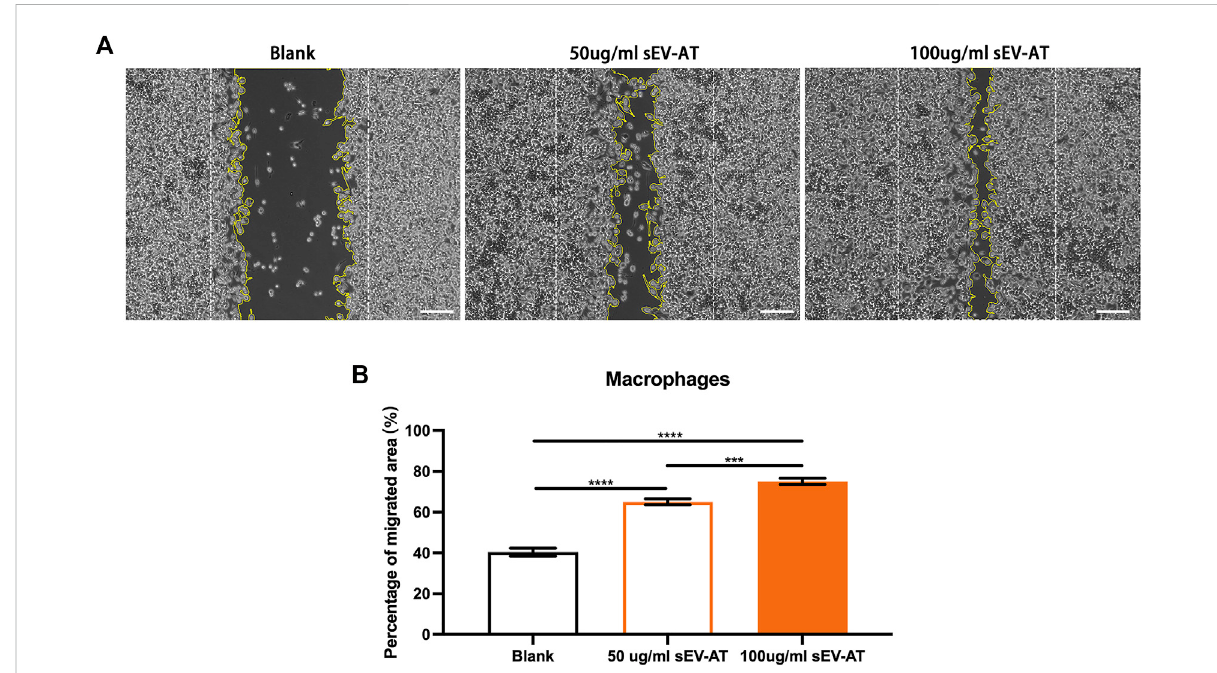
FIGURE 6 The migration of macrophages induced by sEV-AT in vitro . (A) Representative images of scratch assays at 30 h. The white dotted lines pointed out the border of the scratches at 0 h. The yellow lines pointed out the border of the migrated cells at 30 h. Scale bar = 200 μ m . (B) The relative migrated areas per fi eld of view (scale bar = 200 μ m) were analyzed (n = 3). The signi fi cance was tested with ordinary one-way ANOVA followed by Tukey ’ s multiple comparisons test. ( ***p < 0.001, ****p < 0.001